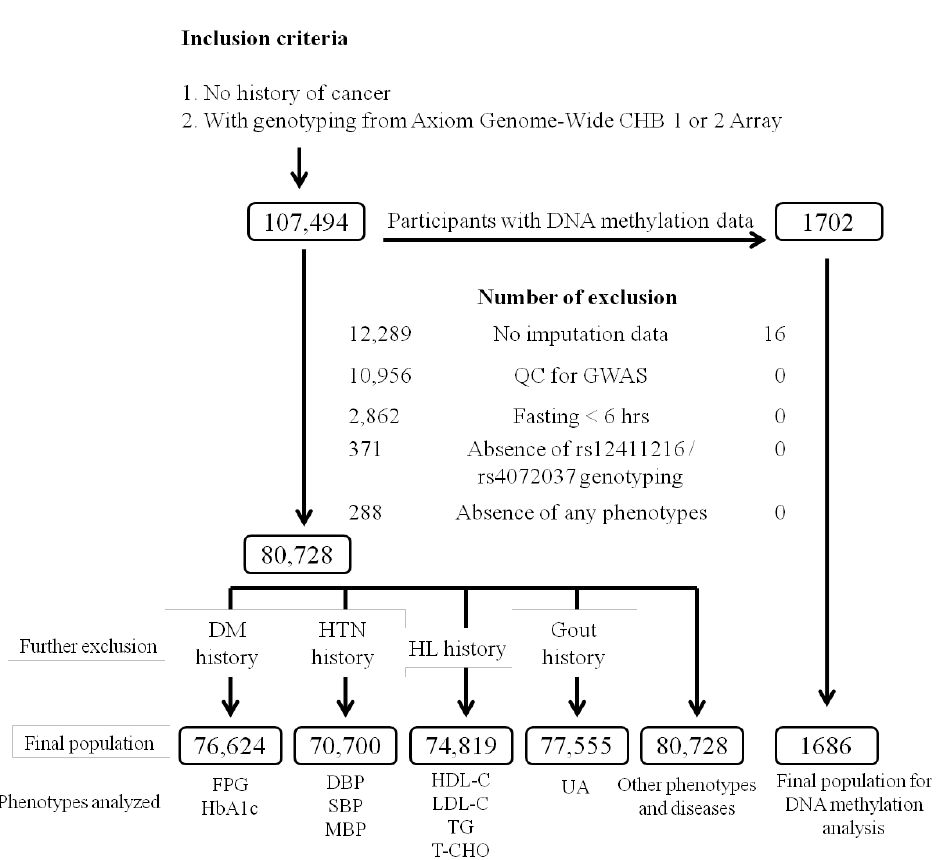
Figure 5. Study inclusion and exclusion criteria flowchart. This flowchart presents the inclusion and exclusion criteria used to screen for Taiwan Biobank (TWB) participants. GWAS: genome-wide association study, QC: quality control, HL: hyperlipidemia, HTN: hypertension, DM: diabetes mellitus, FPG: fasting plasma glucose, HbA1C: hemoglobin A1C, SBP: systolic blood pressure, DBP: diastolic blood pressure, MBP: mean blood pressure, LDL-C: low-density lipoprotein cholesterol, HDL-C: high-density lipoprotein cholesterol, TG: triglyceride, T-CHO: total cholesterol, UA: uric acid. Other phenotypes include: age, body mass index (BMI), waist circumference, waist–hip ratio, aspartate aminotransferase (AST), alanine aminotransferase (ALT), γ -Glutamyl transferase ( γ -GT), serum creatinine level, estimated glomerular filtration rate (eGFR), serum albumin, total bilirubin, hemoglobin, hematocrit, red blood cell, leukocyte, and platelet counts, blood urea nitrogen (BUN), albuminuria, microalbuminuria, current smoking status, metabolic syndrome.